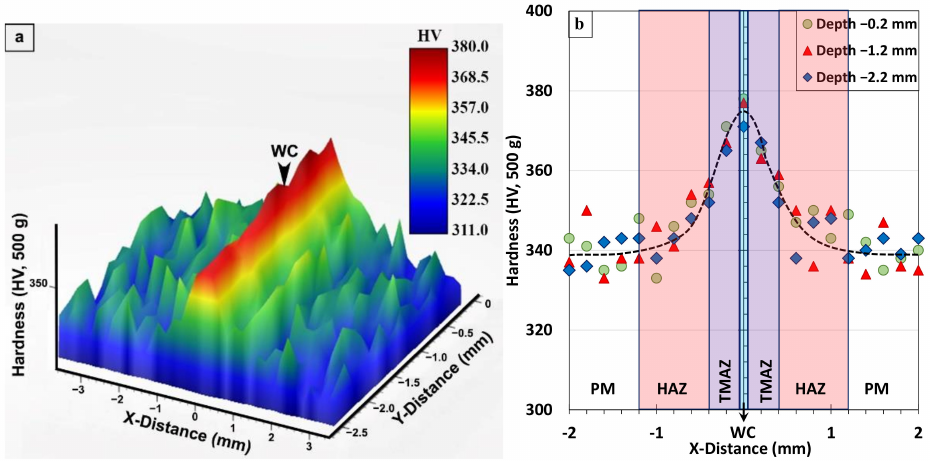
Figure 9. Hardness of Ti-6242 weld in SRAed condition: ( a ) 3D map and ( b ) profiles showing the different regions; x-distance and y-distance are along the joint length and depth,